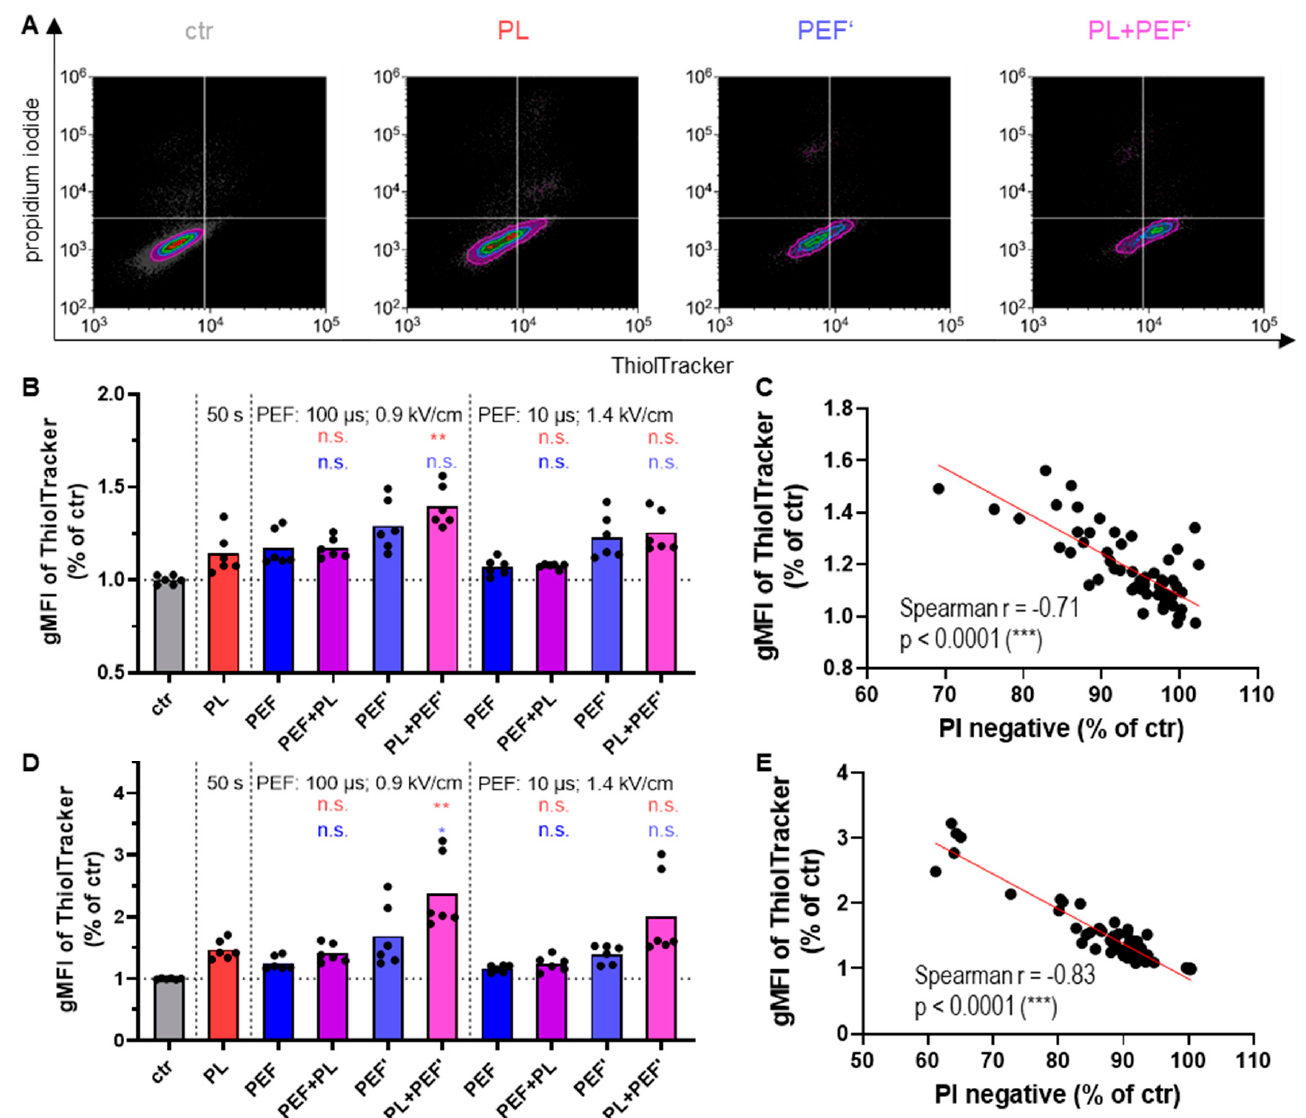
Figure 5. Thiol content of Jurkat cells in DMEM after plasma and PEF treatment. The thiol content of the viable cells was determined by ThiolTracker Violet after 4 h ( B ) and 24 h ( A , D ). Concurrently, the cell viability was measured via PI. Data are shown as one representative ( A ) or mean from three independent experiments with several replicates each ( B , D ). The analysis for total thiol content in relation to the PI negative cells was performed using nonparametric, two-tailed Spearman correlation with 95% confidence intervals after 4 h ( C ) and 24 h ( E ). The fluorescence intensity of the dyes was evaluated via flow cytometry. One-way ANOVA with Turkey’s multiple comparison test was performed (*: p < 0.05 and **: p < 0.01). ctr: control; PL: plasma; PEF: pulsed electric field; PEF’: cells were seeded into 96-well plates before being transferred into cuvettes; ns: not significant; gMFI: fluorescence intensity of the geometric mean.